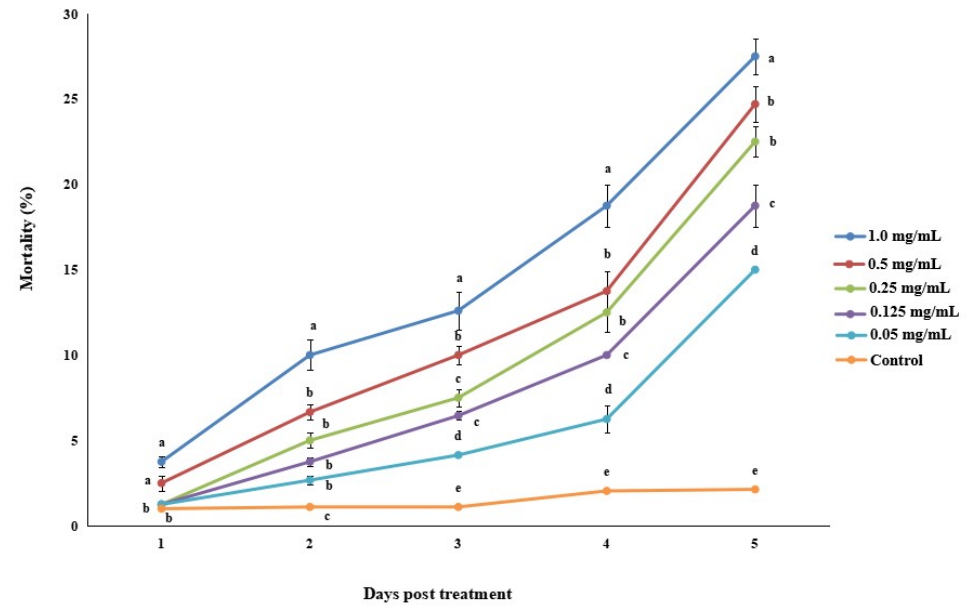
Figure 3. Percentage mortality of M. usitatus treated with different concentrations of matrine at different time intervals. Error bars indicate standard error of means based on three replicates. Bars having different letters at different days post treatment were significantly different from each other. Table 1. Mean percentage adjusted mortality of M. usitatus following single or joint treatments of A. attenuatus and matrine.